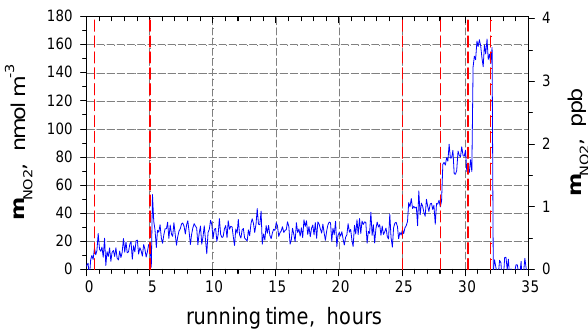
Fig. 8. Temporal course of blended NO 2 concentrations (12.3, 24.6, Figure 8. Temporal course of blended NO 2 concentrations (12.3, 24.6, 41.0, 73.8, and 3 41.0, 73.8, and 139.4nmolm − 3 (0.3, 0.6, 1.0, 1.8, 3.4ppb)) used for 139.4 nmol m -3 (0.3, 0.6, 1.0, 1.8, 3.4 ppb)) used for fumigation of young spruce trees during 4 fumigation of young spruce trees during the laboratory experiments. the laboratory experiments. NO 2 concentrations were provided by diluting a NO 2 standard 5 NO 2 concentrations were provided by diluting a NO 2 standard into into purified air. Red dashed lines indicate times where blending was changed to obtain the 6 purified air. Red dashed lines indicate times where blending was next NO 2 concentration. 7 changed to obtain the next NO 2 concentration.